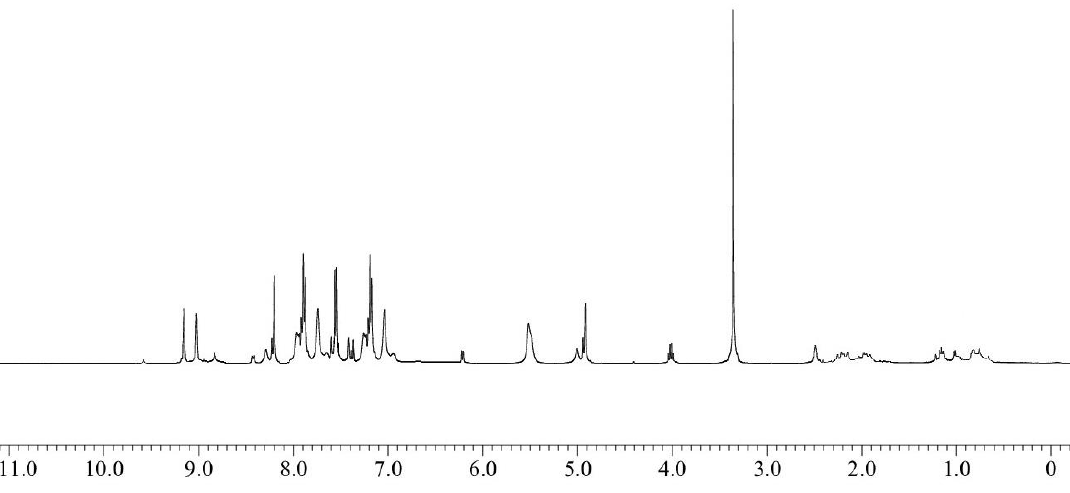
Figure 2. 1 H NMR spectrum of phthalimide pendent novolac 5a . Table 1. Phthalimide- and naphthalimide-substituted phenol-formaldehyde polymeric resins 5a − c and 9a − d . S.No.